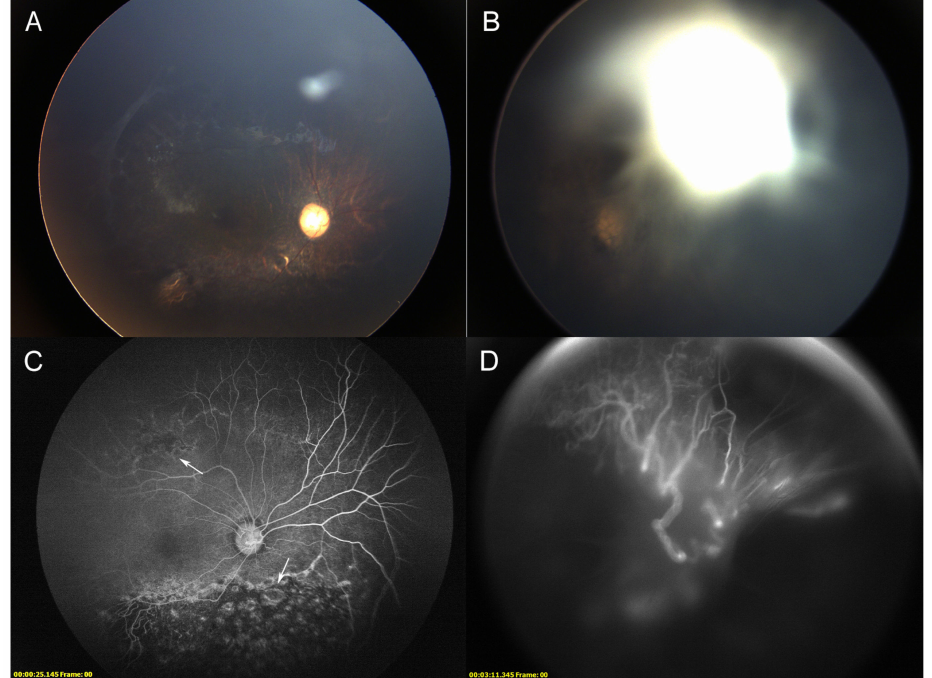
Figure 4. Color fundus (CF) and fluorescein angiography (FA) photographs of patient 0151230. CF photographs show patches of chorioretinopathy predominately located on the inferior retina and marked vascular attenuation in the right eye ( A ), and a tractional RD in the left eye ( B ). FA images highlight poorly developed retinal vasculature ( C , D